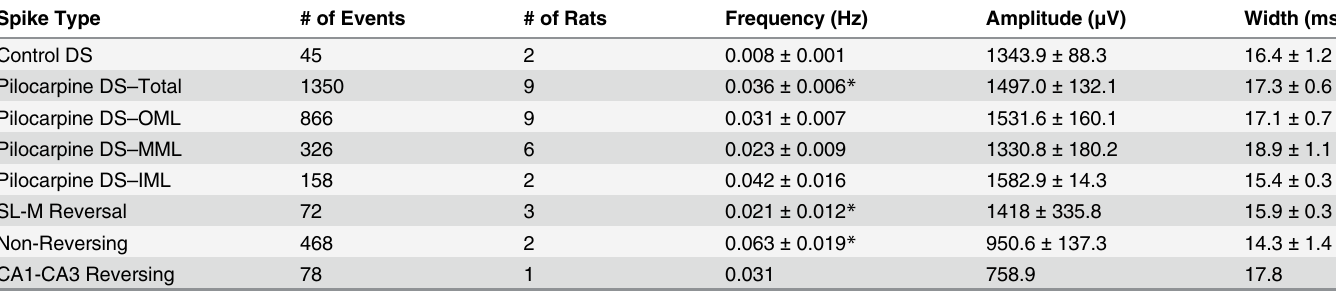
Table 1. Summary of all events and spike types observed in pilocarpine and control treated